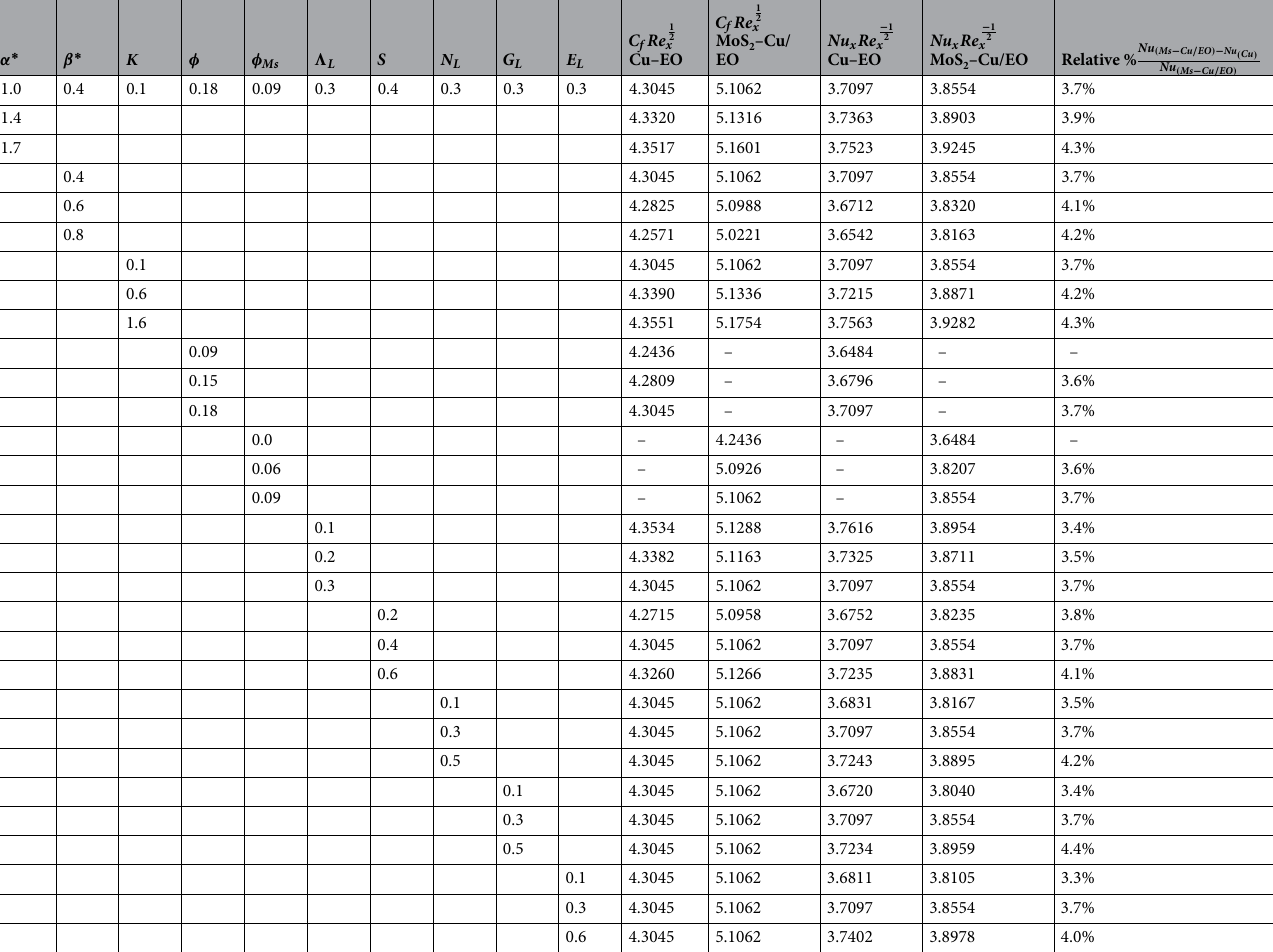
1 / 2 x and Nu x Re